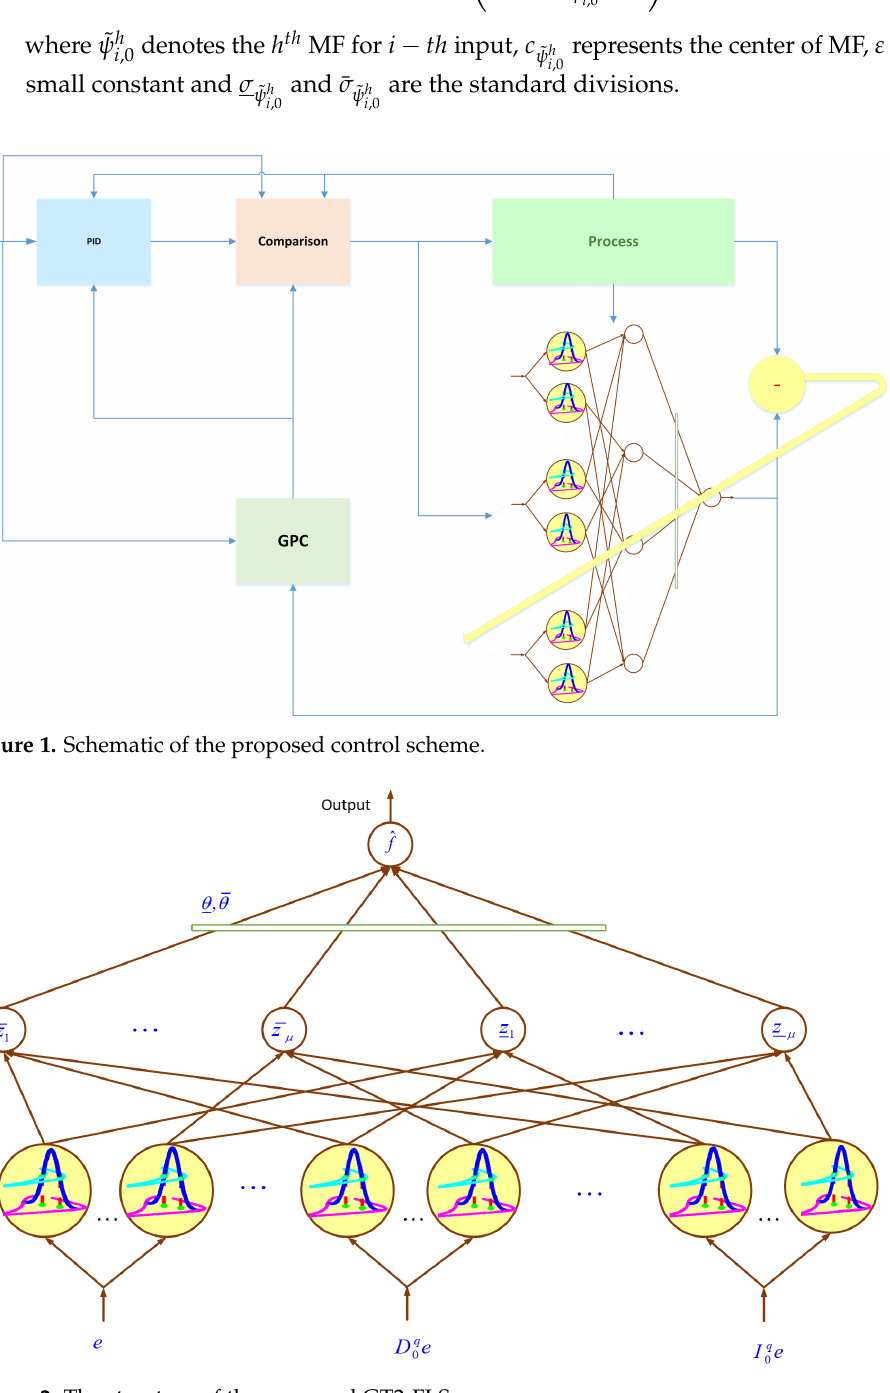
Figure 2. The structure of the proposed